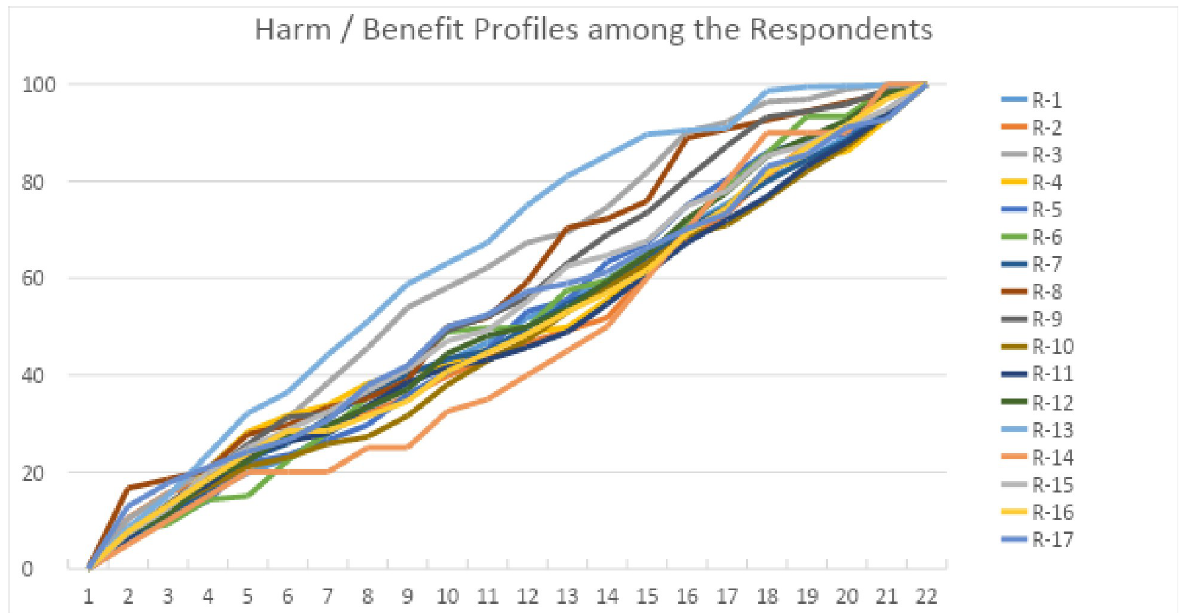
Fig 4. A CDF-like display of the harm / benefit